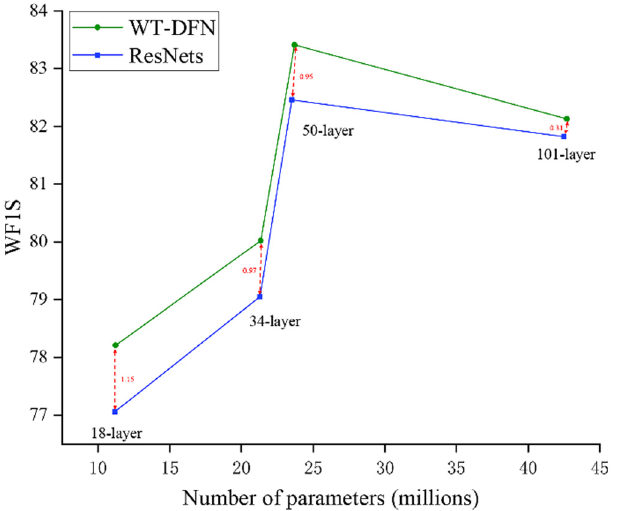
Figure 6. WF1S comparison on C-NMC. With similar number of parameters, our method consistently outperforms the baseline ResNet by a large margin.